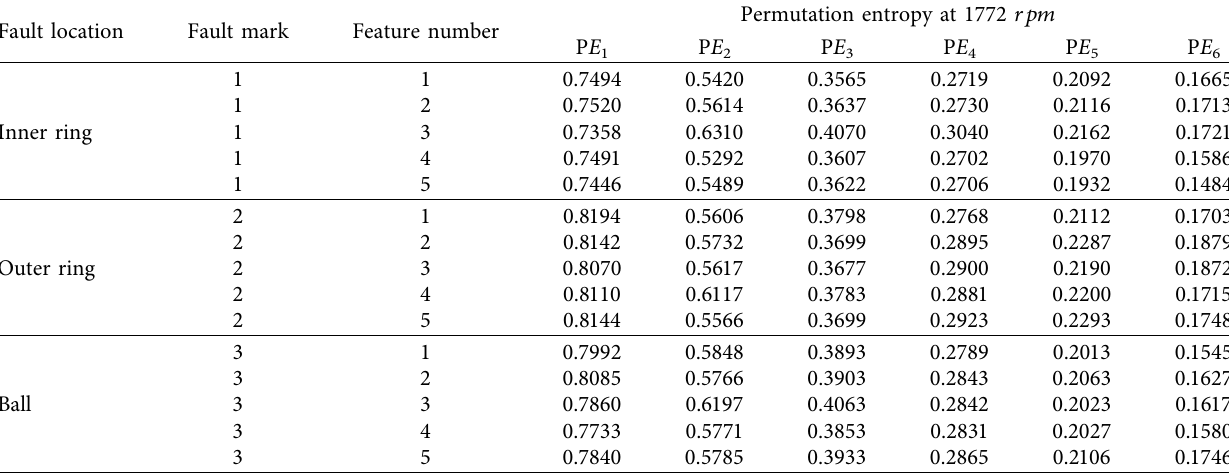
Table 7: Permutation entropy at 1772